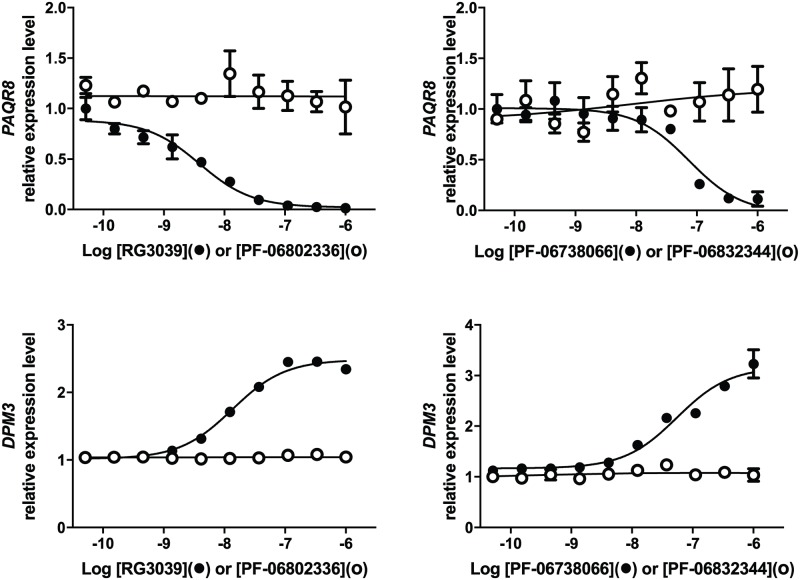
Effect of active DAQ-DcpSi and their 7-methyl analogues on PAQR8 and DPM3 transcripts.SMA-derived lymphoblasts were treated with active DAQ-DcpSi (RG3039, PF-06738066) or their 7-methyl analogues (PF-06802336 and PF-06832344 respectively) and the levels of PAQR8 and DPM3 transcripts measured using ddPCR. All data shown as mean ± s.e.m. and where not shown error bars are within the size of the symbols. Significant P-values were denoted as P<0.05 (*), P<0.01(**), P<0.001(***), P<0.0001(****).